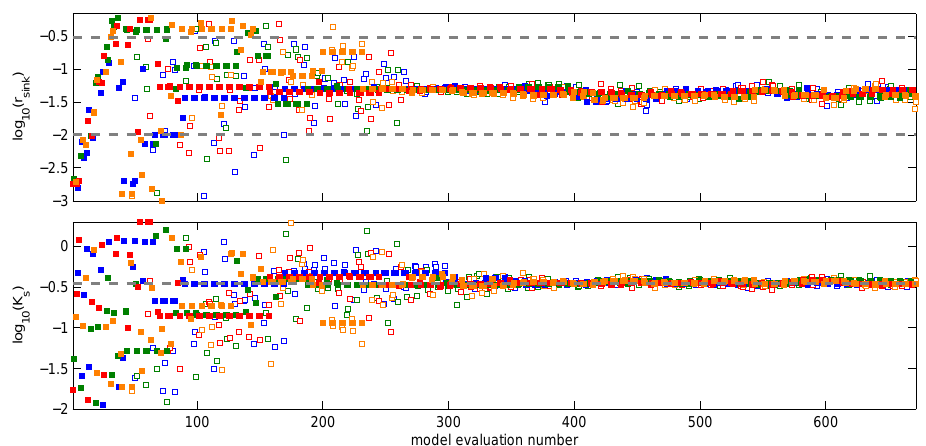
Fig. 4. SCEM-UA (idealized data set): evolution of the parameters. Dashed lines represent value of r sink ( low ) and r sink ( high ) (upper plot) and K s (lower plot). Markov chains are color-coded; open symbols are samples that have been rejected by the Metropolis scheme, while solid colors have been accepted. Note that the vertical axes are logarithmic.